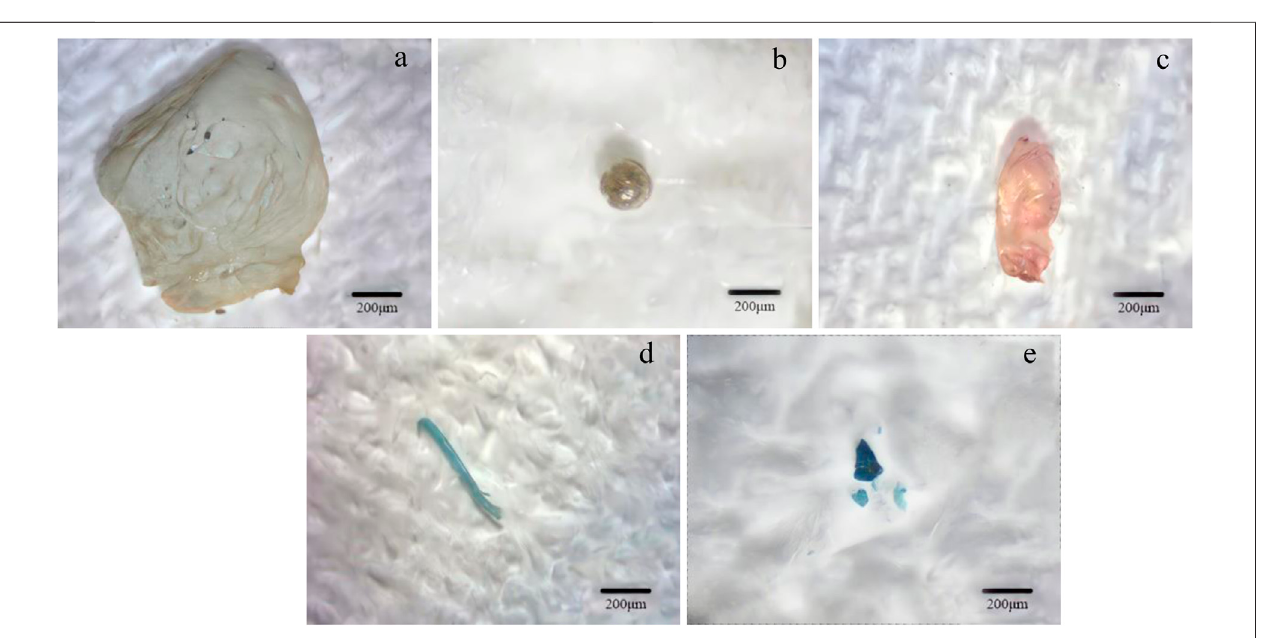
FIGURE 4 | Types of microplastics [ (A) : white foam, (B) : transparent pellet, (C) : red fi lm, (D) : blue fi ber, (E) : blue fragment].